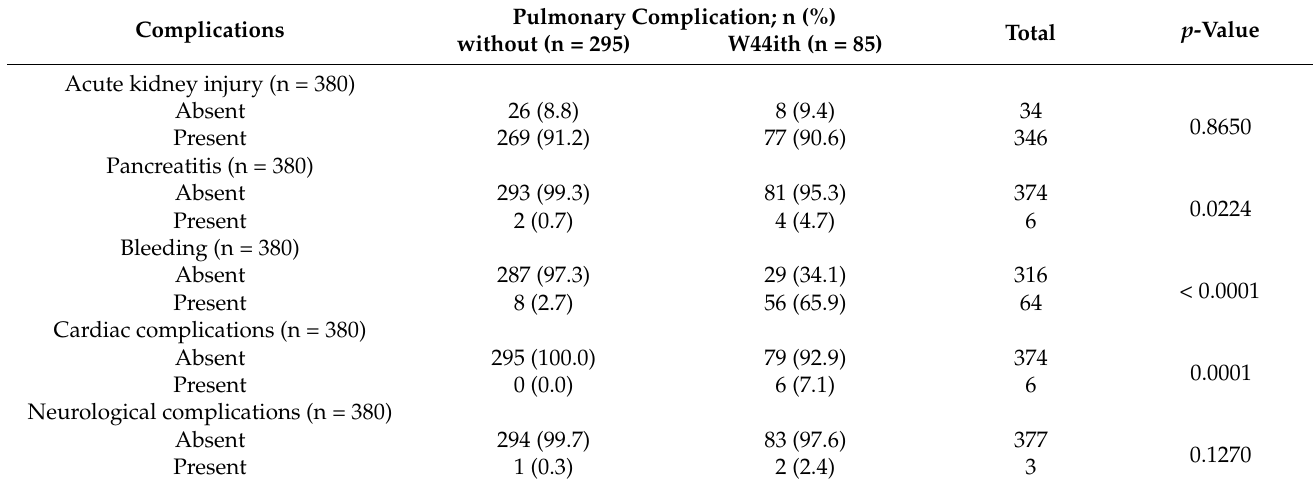
Table 3. Distribution of pulmonary outcome according to complications.